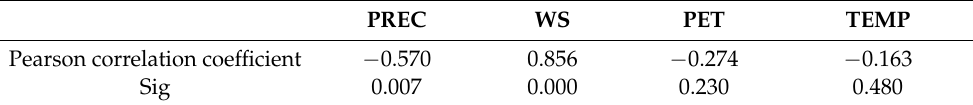
Table 6. Correlation test between climatic factors and desertification area. PREC WS PET TEMP Pearson correlation coefficient − 0.570 0.856 − 0.274 − 0.163 Sig 0.007 0.000 0.230